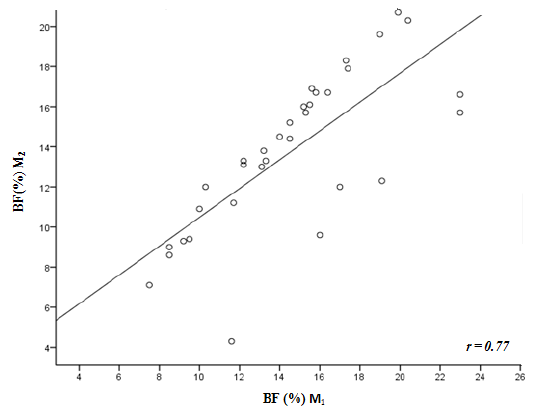
Figure 7. Correlation between the values of param- eters measured by Nutriguard-M before and after the intake of fluids – body fat (%)